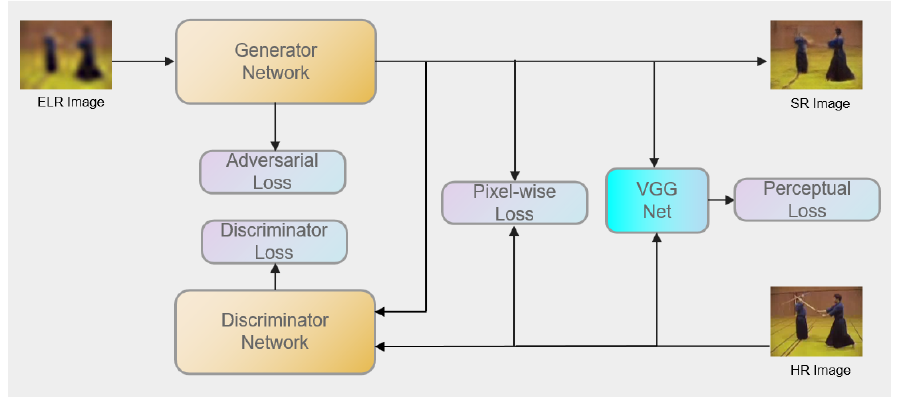
Figure 2. The general architecture of our super-resolution module. ELR denotes extreme low resolution, and SR and HR represent super-resolution and high resolution,